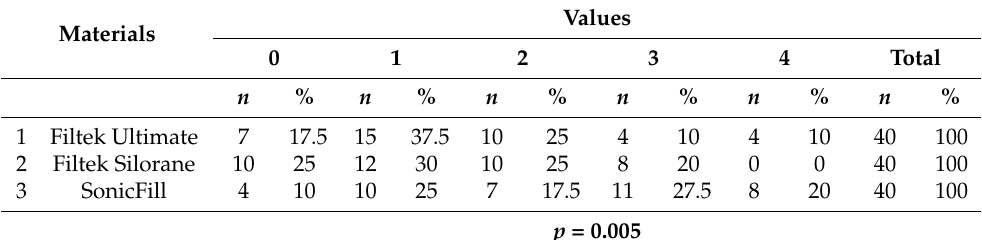
Table 5. Results of micropermeability